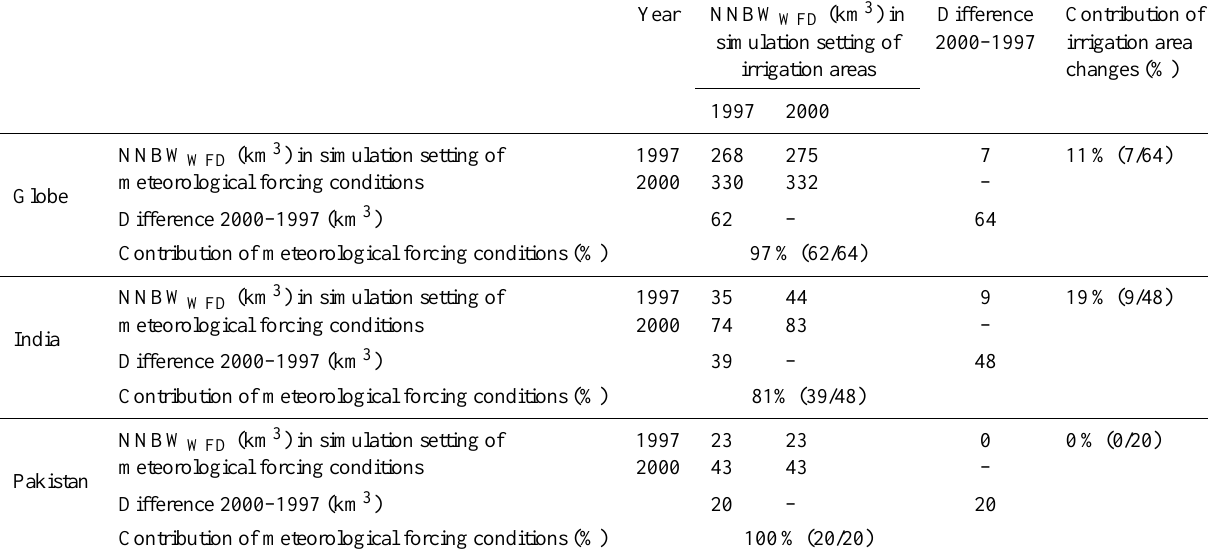
Table 5. Sensitivity analysis for the contribution of NNBW WFD using combinations of irrigation areas and meteorological forcing conditions in the years 1997 and 2000 for the globe, India and